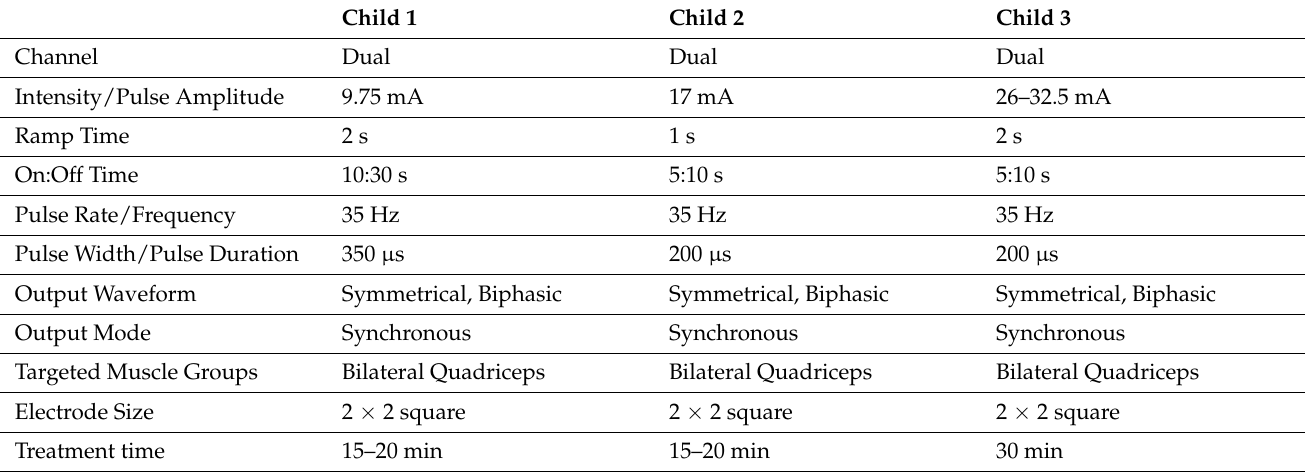
Table 2. Neuromuscular electrical stimulation